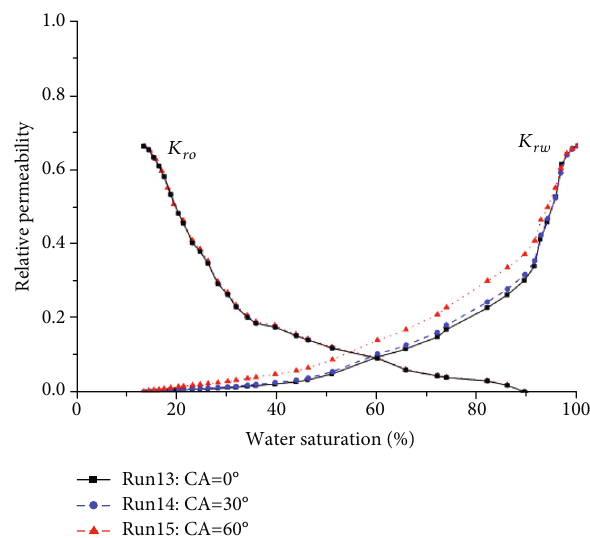
Figure 13: E ff ect of wettability conditions on relative permeability.